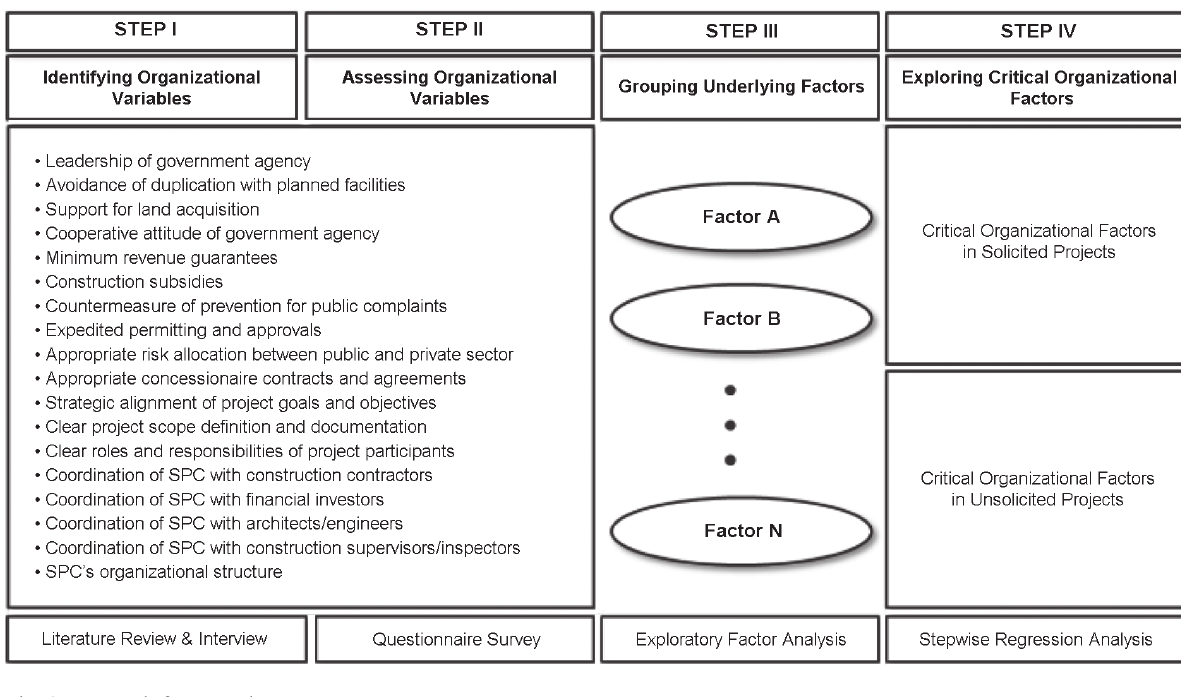
Fig. 3. Research framework